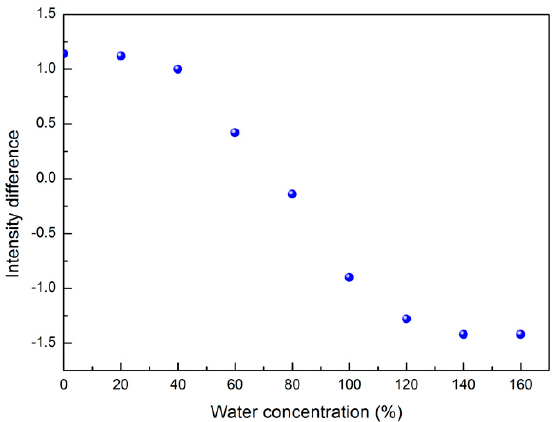
Figure 5. Peak intensity difference between the contribution centered at ~3247 cm − 1 and the contri- bution centered at ~3330 cm − 1 as a function of water concentration for BS-SBP3.